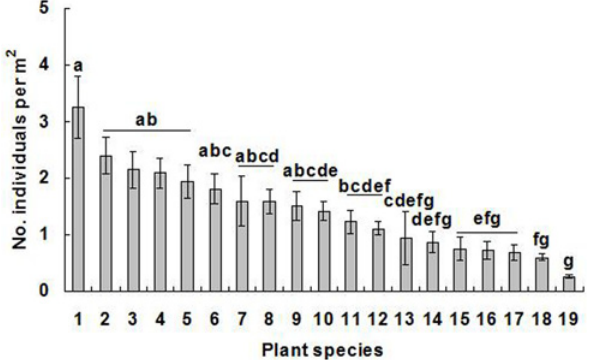
Fig 1. Population density of Apolygus lucorum on 18 preferred host plant species in the summers from 2006 – 2012 at Langfang (Hebei Province, Northern China). The average densities of A . lucorum on the 18 plant species were higher than 0.5 individuals per m 2 . The data in the figures were shown as mean ± SE. In each figure, bars with the same letters are not significantly different at the 0.05 level. Plant species: 1 Artemisia lavandulaefolia DC., 2 Artemisia argyi Lévl. et Vant., 3 Vigna radiata (L.) Wilczek, 4 Artemisia annua L., 5 Artemisia scoparia Waldst. et Kit., 6 Impatiens balsamina L., 7 Agastache rugosus (Fisch. et Meyer) O. kuntze., 8 Cannabis sativa L., 9 Ricinus communis L., 10 Humulus scandens (Lour.) Merr., 11 Ocimum basilicum L., 12 Gossypium hirsutum L., 13 Amaranthus hypochondriacus L., 14 Polygonum orientale L., 15 Helianthus annuus L., 16 Mentha haplocalyx Briq., 17 Medicago sativa L., 18 Fagopyrum esculentum Moench. The last bar (No. 19) showed that the mean density of A . lucorum on all tested plant species during these 7 years.